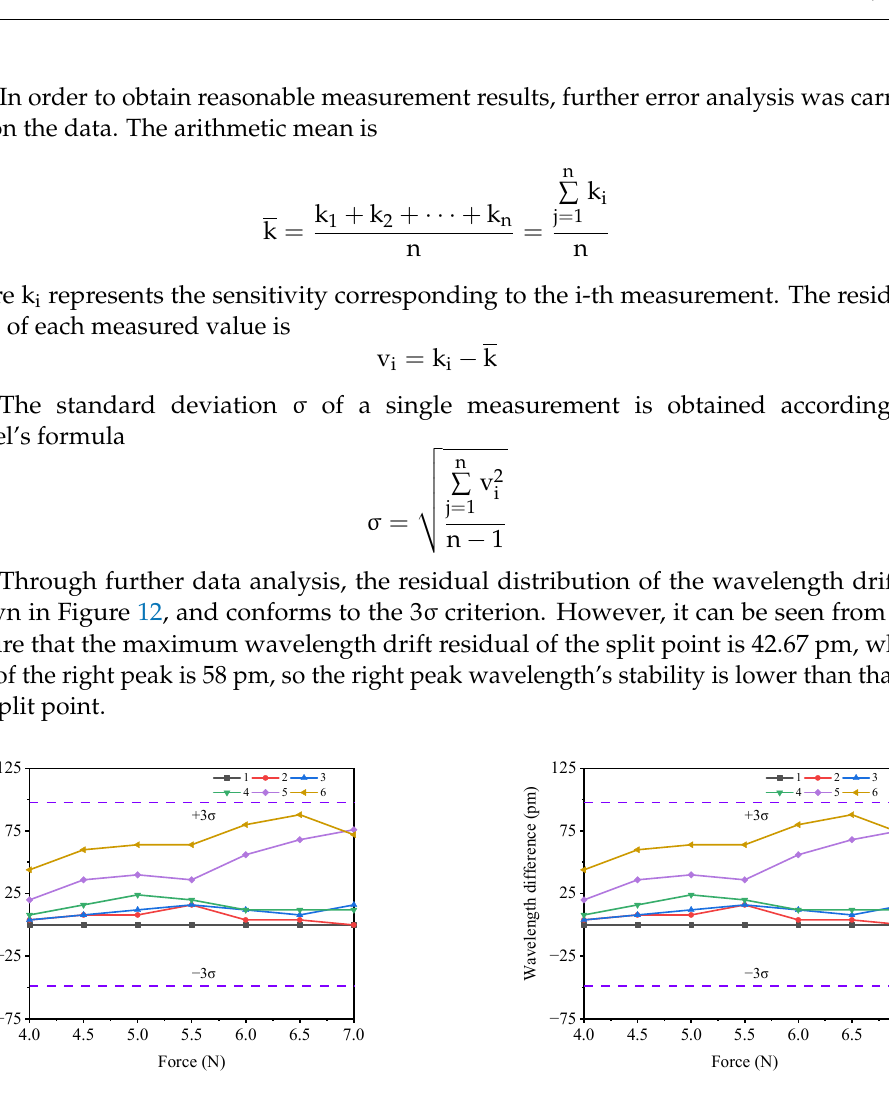
Figure 11. Repeatability analysis: ( a ) split point, ( b ) right peak.